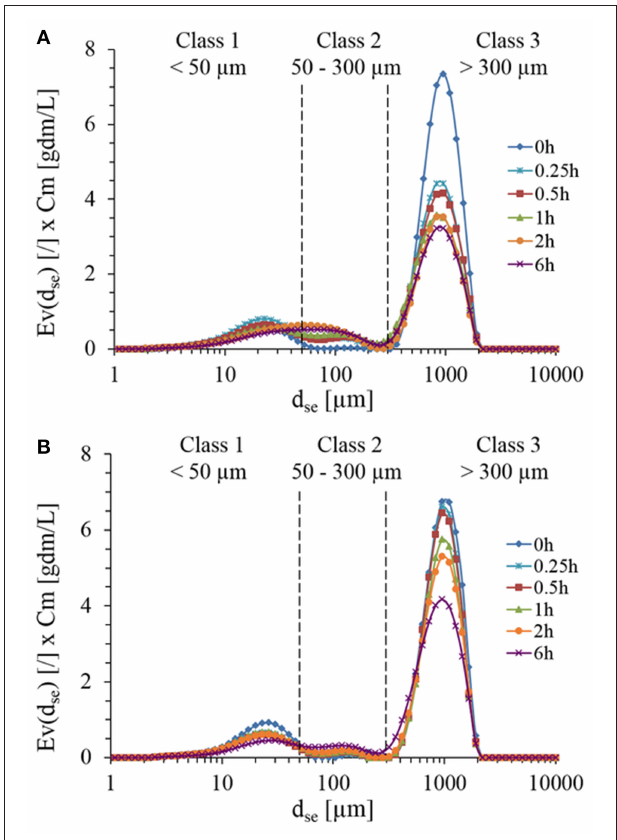
FIGURE 3 | Particles size distribution during the treatment of destarched wheat bran suspension in the presence of Rovabio® (A) and xylanase C (B) . The particle size distribution was assimilated to a diameter of equivalent sphere (dse) and was plotted with respect to the abundance of particle size which was obtained by multiplying Ev by the concentration of wheat bran suspension (Cm) that remained at each time during the enzymatic treatment. Operating conditions identical to Figure 2